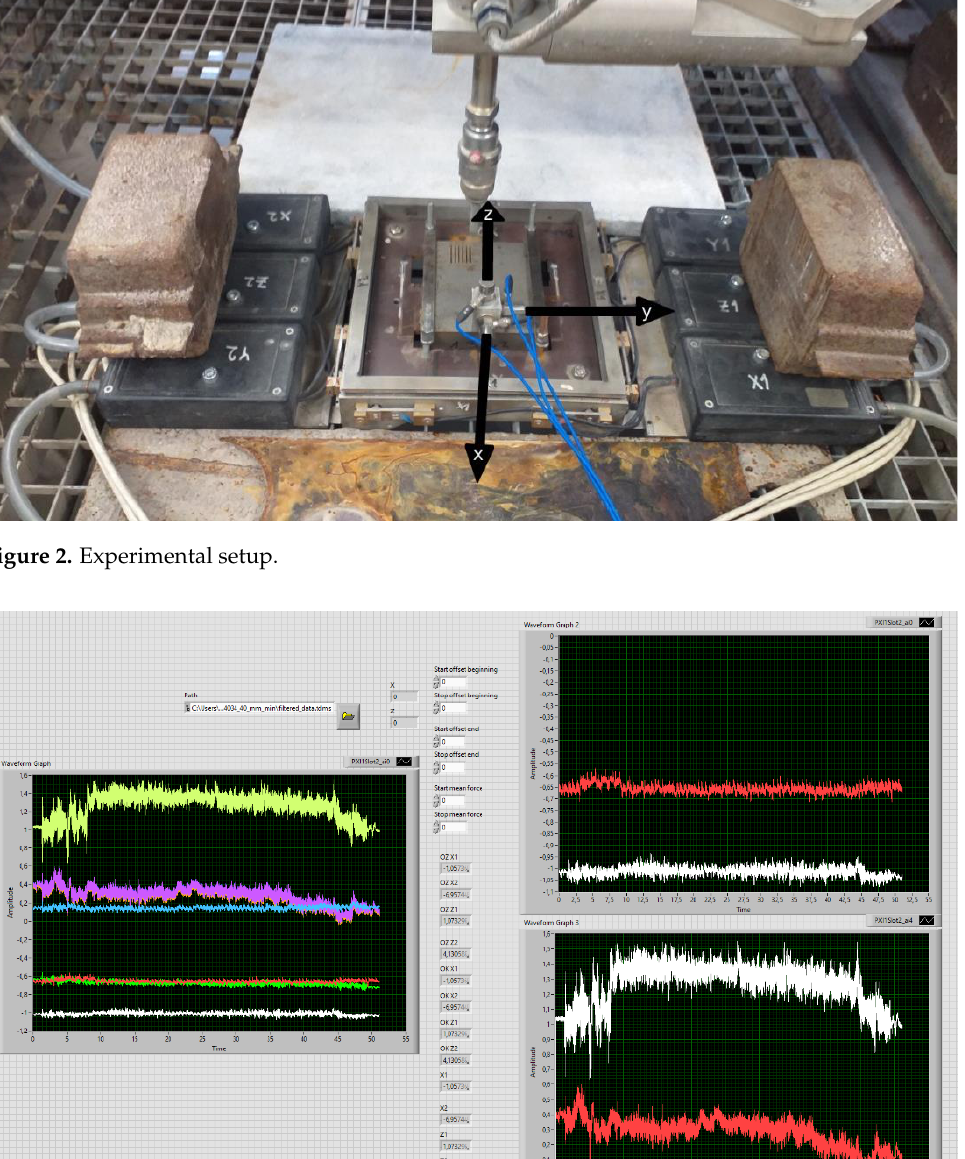
Figure 3. Front panel of the LabVIEW program processing the measured data for steel 1.4034 for the 40 mm/min traverse speed. Table 2. Traverse speeds used during experiments.